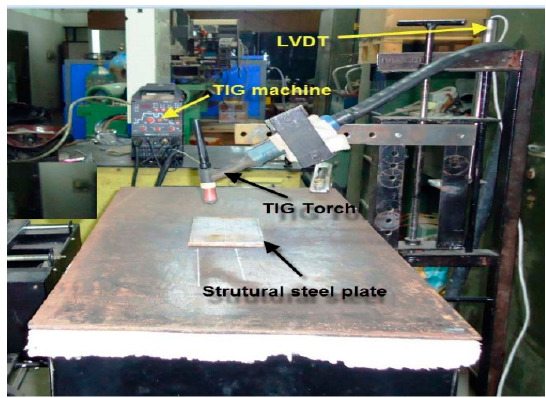
Figure 8. Experimental set-up of the TIG welding process. Table 7. Test data for 27 test experiments of bead-on-plate welds.